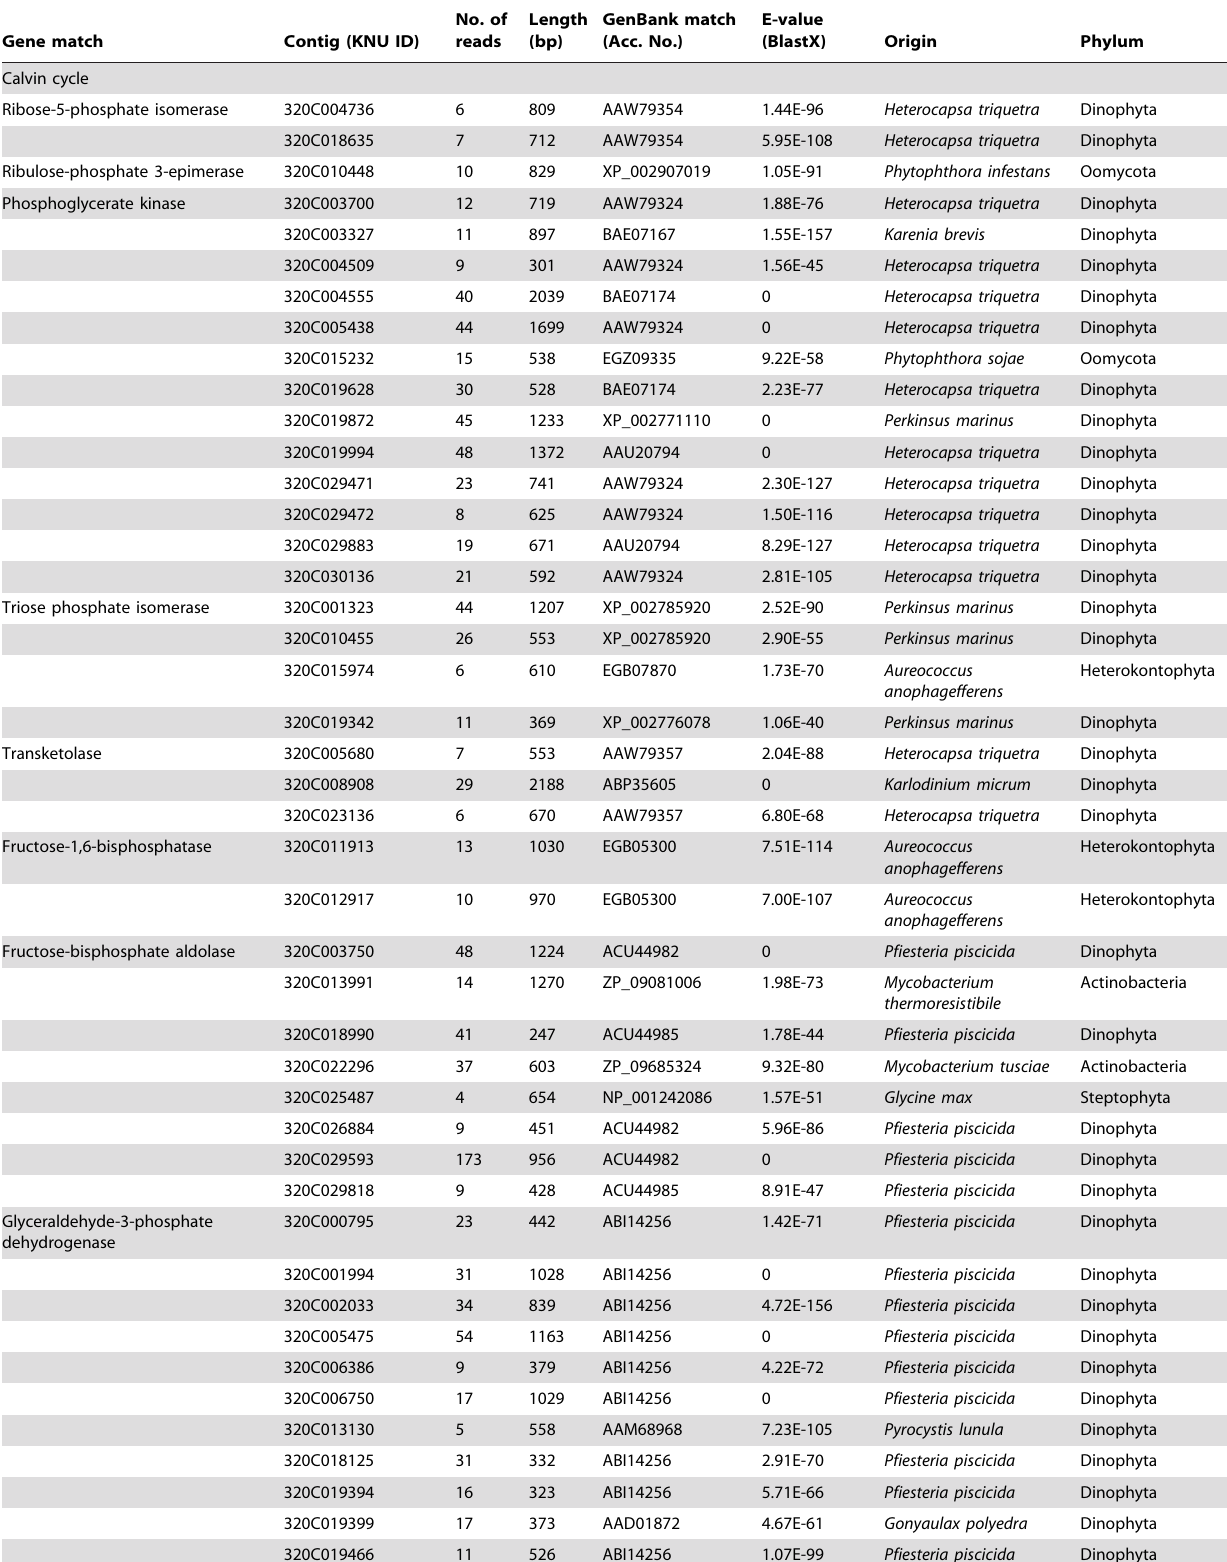
Table 1. Photosynthesis genes involved in Calvin cycle and its associated pathways in Pfiesteria piscicida.